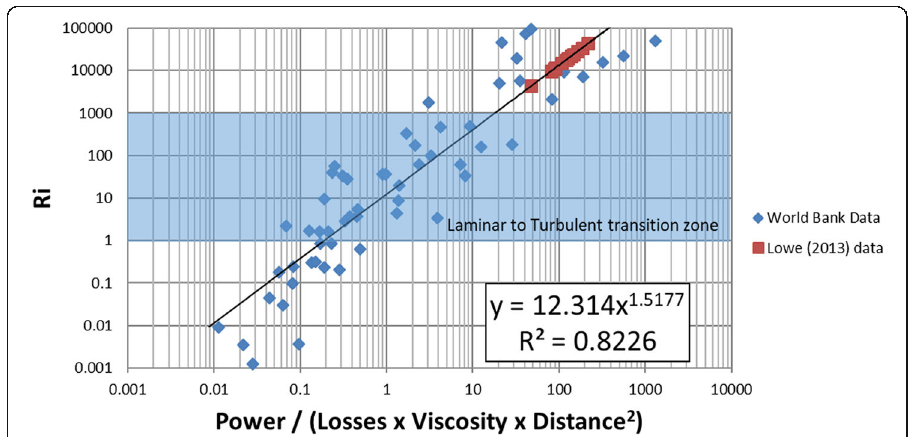
Fig. 26 Improving the state of innovation estimate using the ratio of Power over Losses, Viscosity and Distance